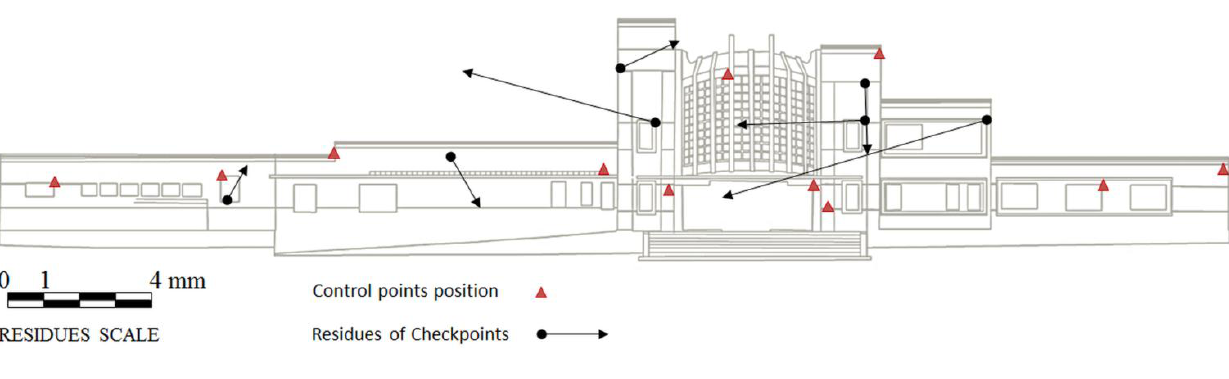
Figure 5. Checkpoints distribution and